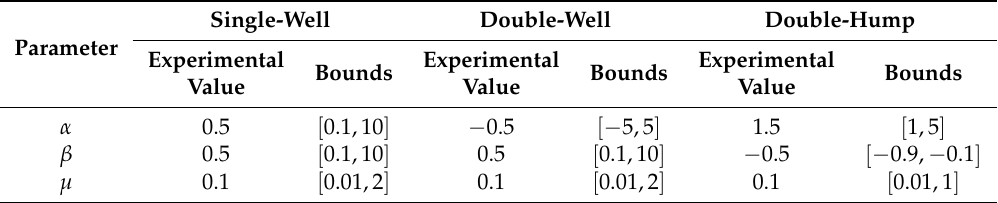
Table 1. Experimental parameters and bounds for the van der Pol–Duffing oscillator [22].